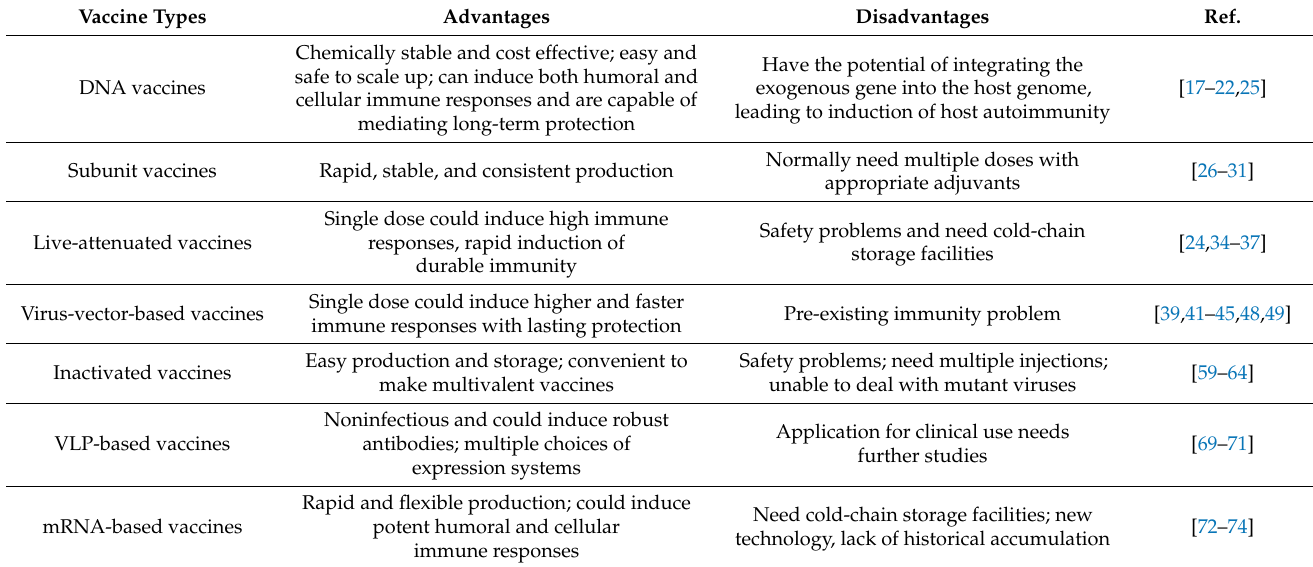
Table 7. Potential advantages and disadvantages of different types of Zika